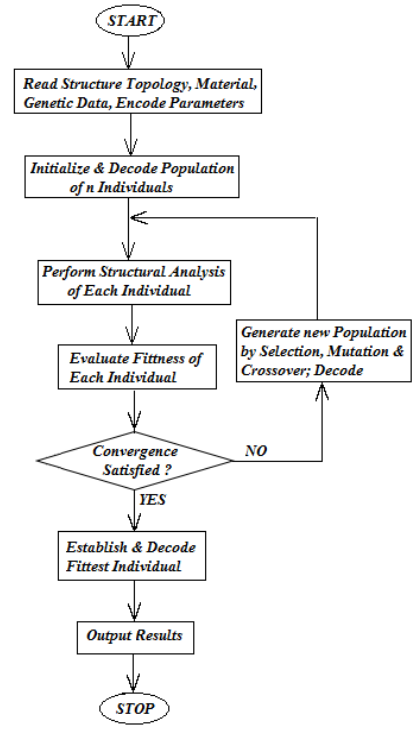
Figure 5. Structural optimization using genetic